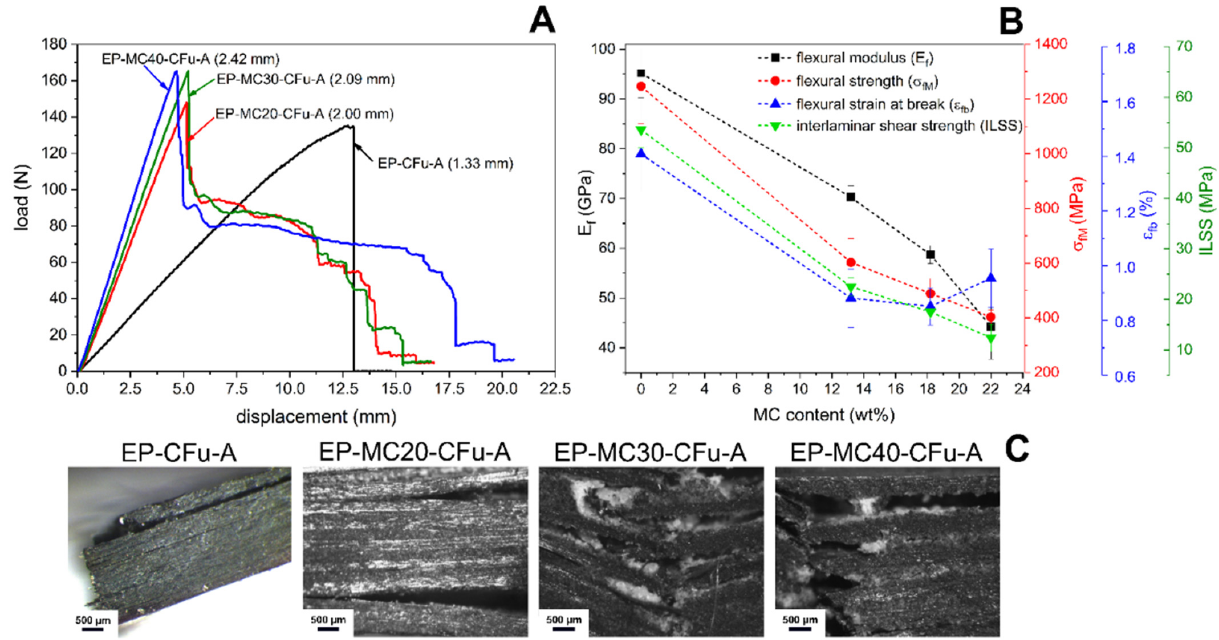
Figure 3. Results of the 3-point bending tests on the laminates EP-MCx-CFu-A and short-beam shear tests on the laminates EP-MCx-CFu-B. ( A ) Representative load–displacement curves. The thickness of the laminates is indicated; ( B ) Flexural modulus ( E f ), flexural strength ( σ fM ), flexural strain at break ( ε fb ) and interlaminar shear strength ( ILSS ) as a function of the MC weight fraction; ( C ) Photographs of the specimens after 3-point bending tests. Reprinted with permission from [41].